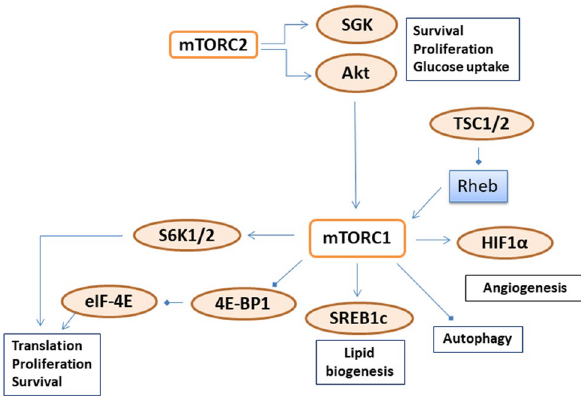
Fig. 1 mTOR signaling pathway in cancer (revised from Zoncu et al. Nature Reviews. 2011 12:21–35). 4E-BP1 eukaryotic translationinitiation factor 4E-binding protein 1; Akt protein kinase B; HIF1α hypoxia-inducible factor 1α; eIF-4E eukaryotic translation initiation factor 4E; mTORC1 mammalian Target of Rapamycin complex 1; mTORC2 mammalian Target of Rapamycincomplex 2; Rheb Ras Homologueenriched in brain; S6K1/2 p70ribosomal S6 kinase 1 and 2; SGK serum- and glucocorticoid-regulated kinase; SREBP1 sterol regulatory element binding protein 1c; TSC1/2 tuberous sclerosis protein 1 and